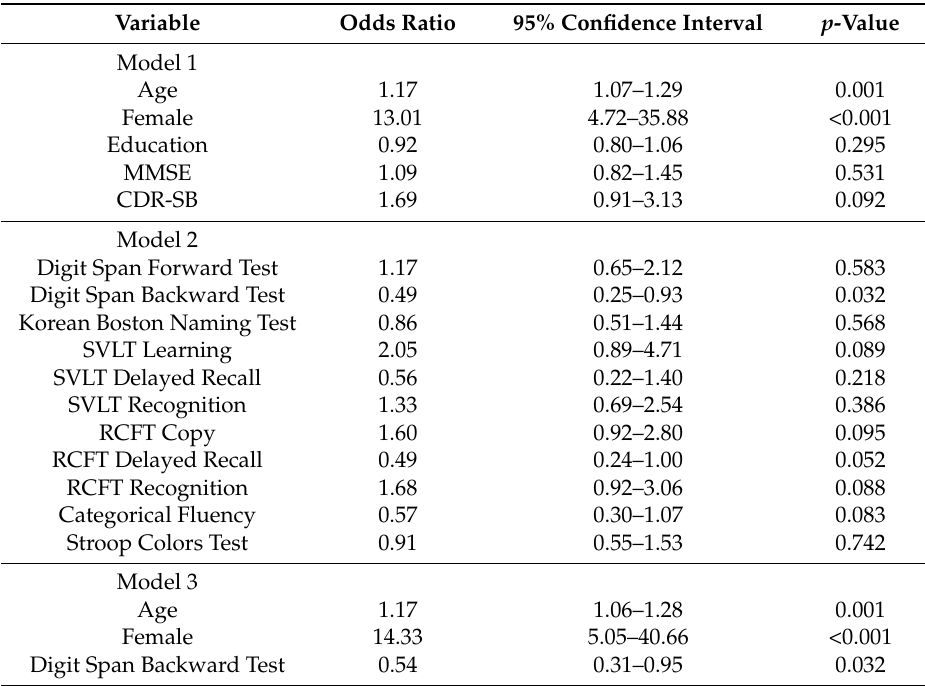
Table 3. Binary Logistic Regression Analysis to assess driving cessation-associated